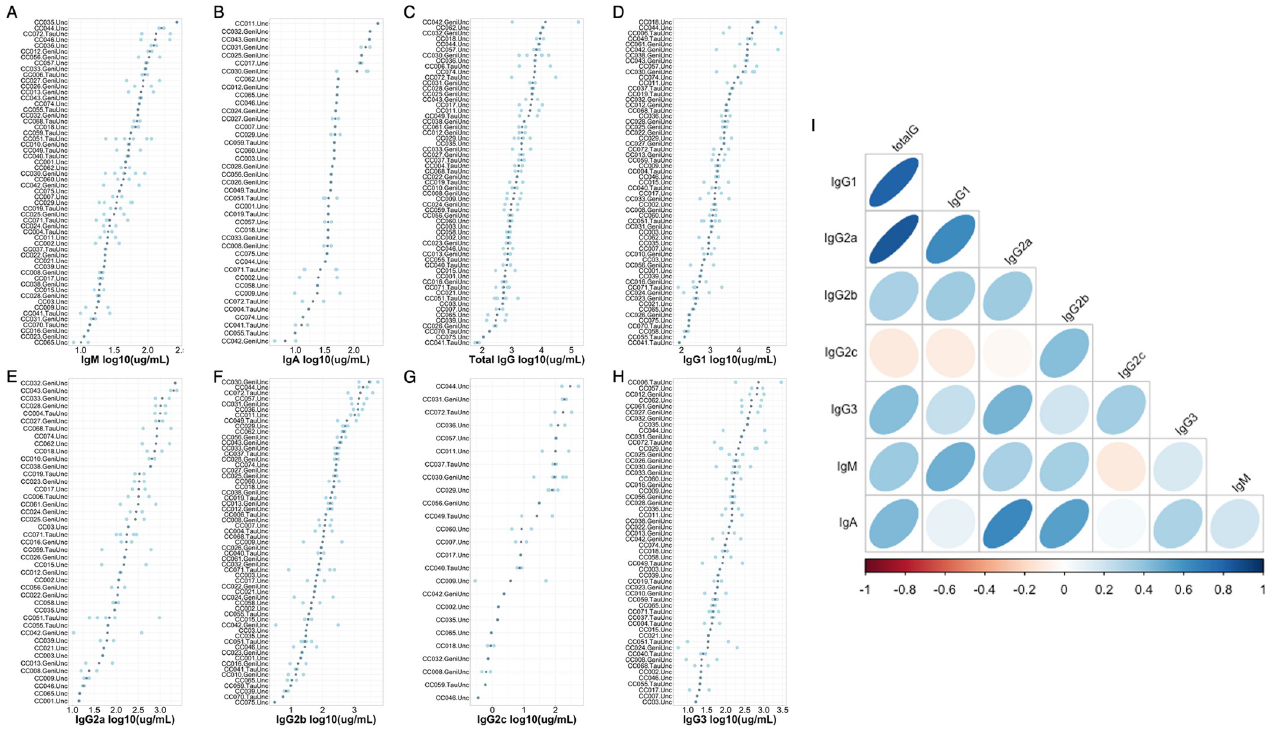
Fig 1. Variation in baseline antibody levels across CC strains and antibody isotypes. Total serum antibody levels for (A) IgM, (B) IgA, (C) total IgG, (D) IgG1, (E) IgG2a, (F) IgG2b, (G) IgG2c, and (H) IgG3 were quantified by ELISAs. Each plot is individually ordered so that the strain with the greatest strain mean is at the top of the plot and the strain with the lowest is at the bottom. Grey dots indicate the mean antibody concentration for an individual strain, and light blue dots indicate individual animal measurements. (I) the relationship between individual antibody isotypes and subtypes in the CC strains. Strains not included for a particular isotype (e.g. Panel B. IgA, Panel E. IgG2a, Panel G. IgG2c) had antibody levels that were undetectable for that isotype.